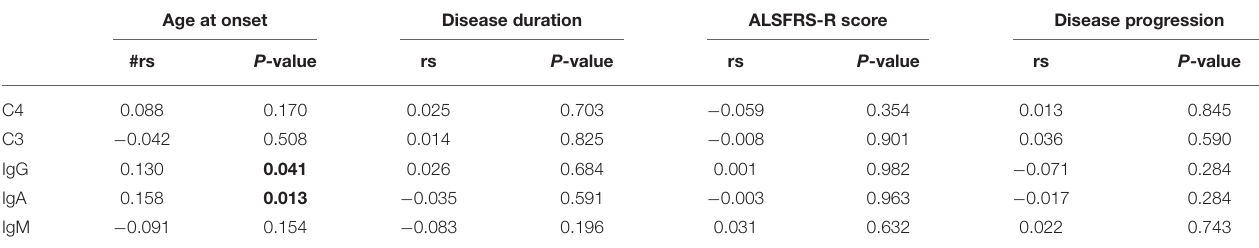
TABLE 3 | Correlation analysis between the serum levels of immunoglobulin or complement and clinical characteristics of ALS. Age at onset Disease duration ALSFRS-R score Disease